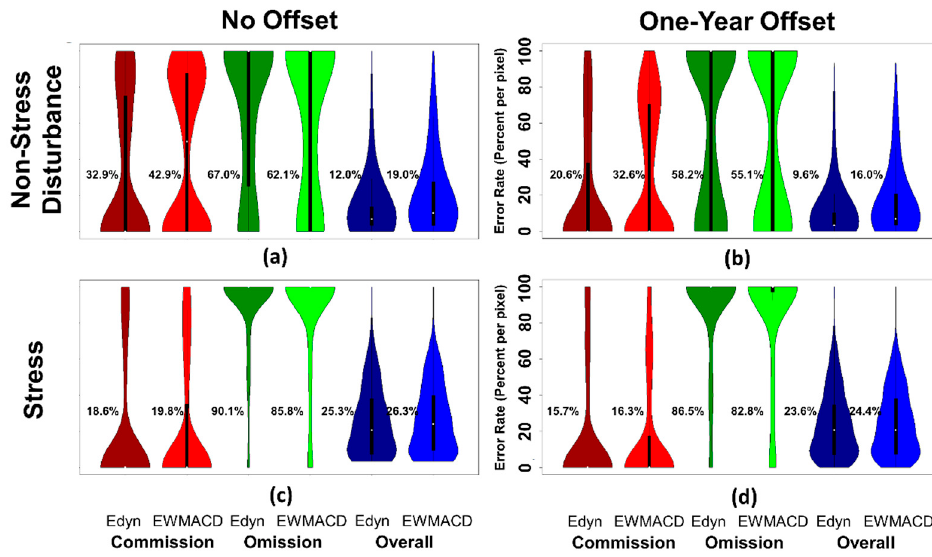
Figure 9. Violin plots of the commission, omission and overall error rates for the subsets of ( a ) disturbed forested pixels excluding stress with no timing offset (1408 pixels); ( b ) disturbed forested pixels excluding stress with a one-year offset (1408 pixels); ( c ) stressed forested pixels with no timing offset (212 pixels); and ( d ) stressed forested pixels with a one-year offset (212 pixels). Mean errors are listed to the left of each violin. Note the bimodal distributions for the commission and omission error rates, as well as the decrease in commission and omission errors for non-stressed forest pixels when allowing the one-year offset.